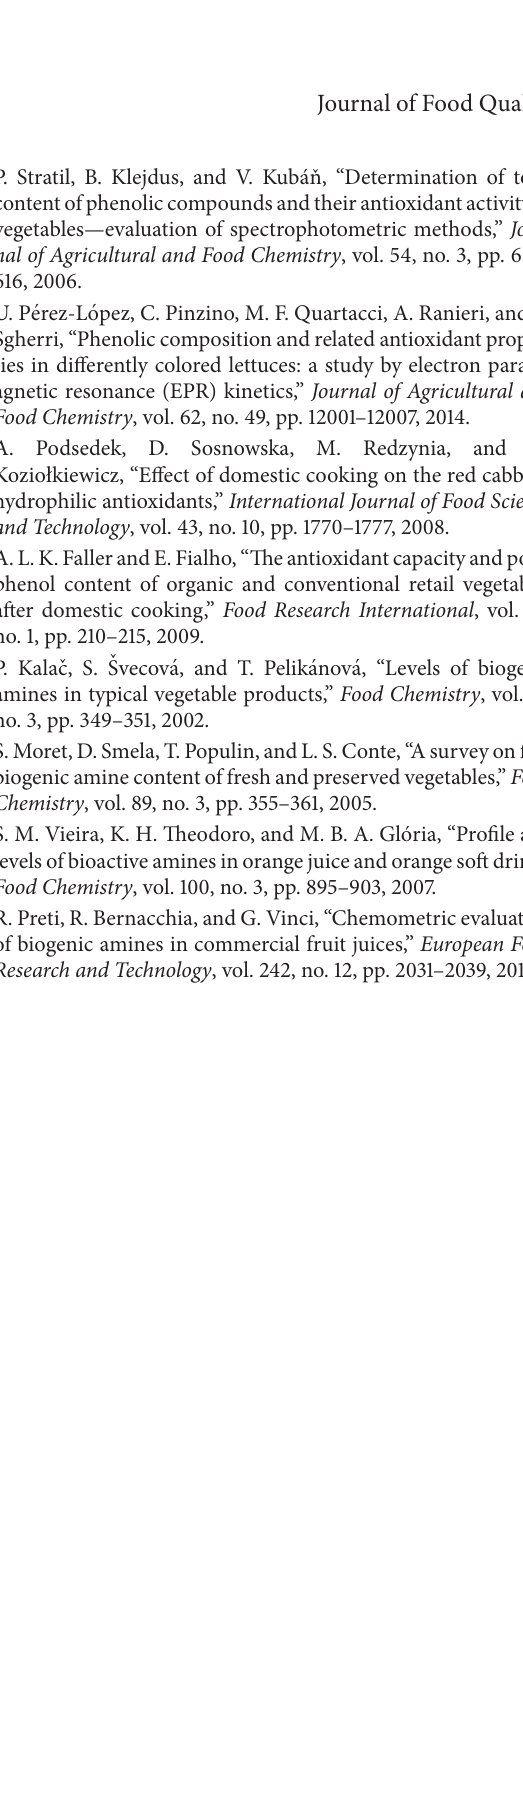
table beets (Beta vulgaris var, conditiva) and green